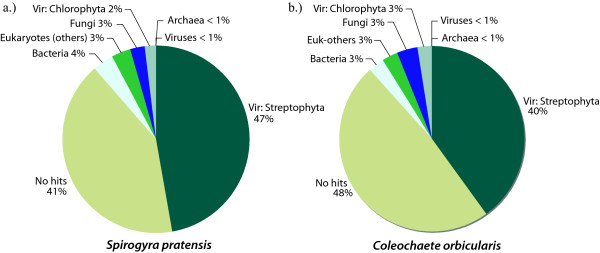
Lineage information. Summary of the lineage information extracted from the top BLASTx hit to NCBI's non-redundant protein database. Vir = viridiplantae. In-house perl scripts were used to query Entrez for taxonomy information.